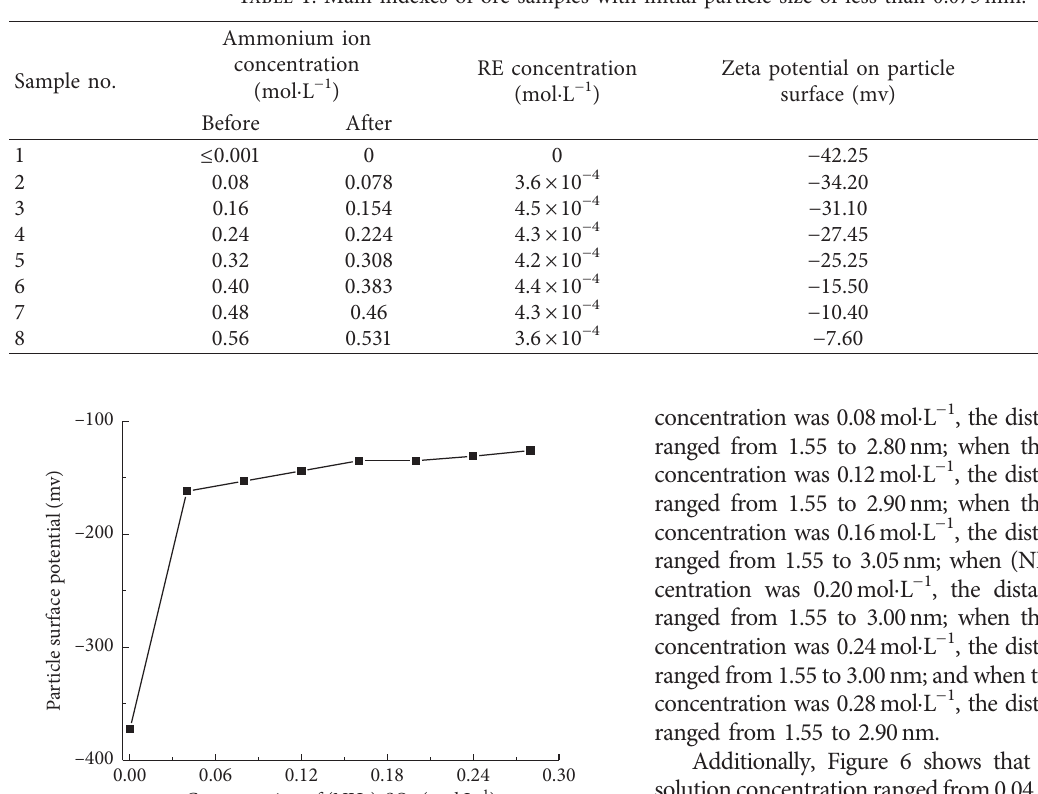
Figure 2: Relationship between (NH and particle surface potential.